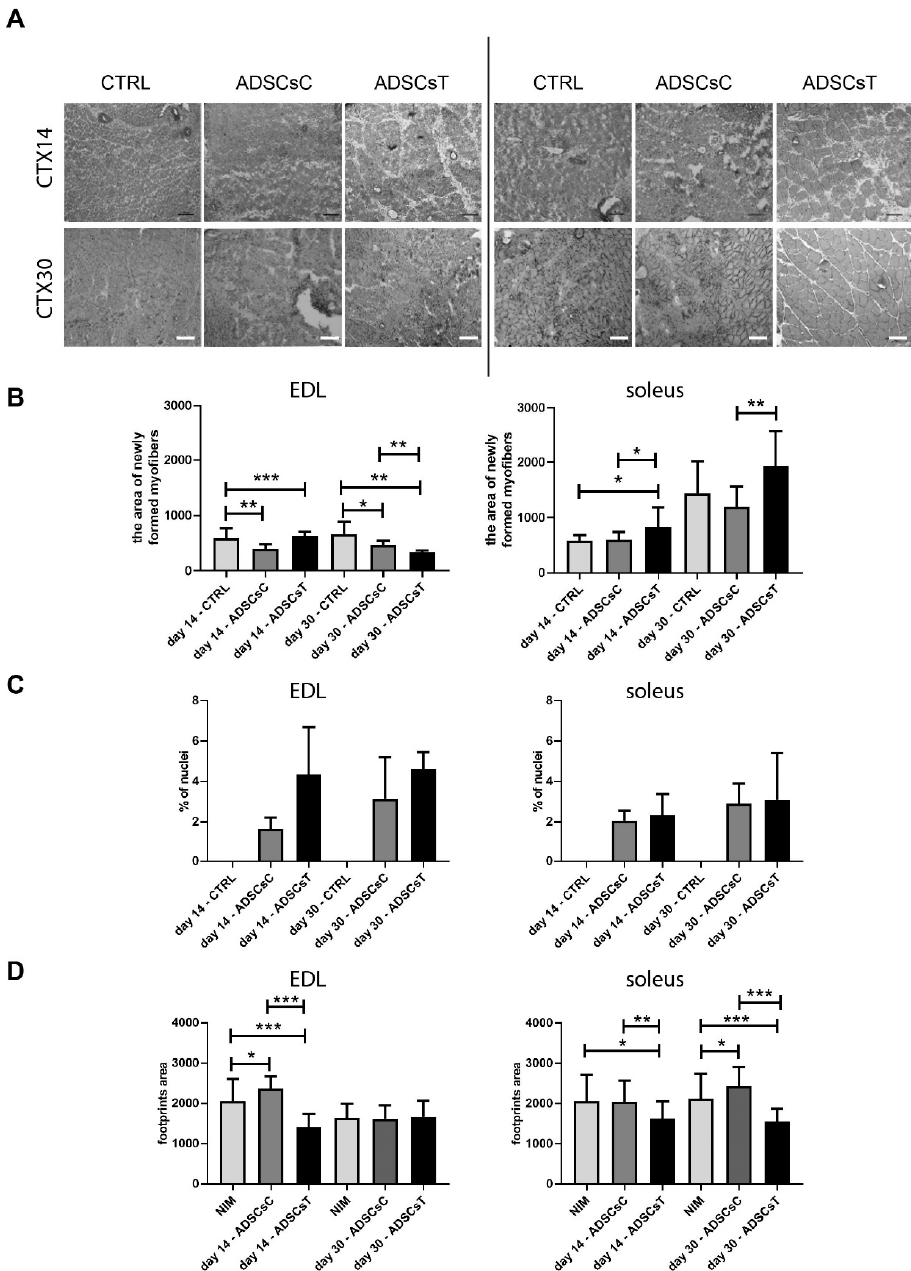
Figure 4. Analysis of muscle morphology, and results of footprint test of rat EDL and soleus skeletal muscles which received control rADSCs or rADSCs pre-treated with IL-4 and SDF-1. ( A ) Morphology of regenerating muscles at days 14 and 30 of regeneration. Hematoxylin/Gomori Trichrom staining; bar: 100 µm. ( B ) Area of newly formed myofibers within the regenerating muscle analyzed at days 14 and 30 of regeneration; ( C ) proportion of centrally positioned nuclei within the regenerating muscle analyzed at days 14 and 30 of regeneration; ( D ) results of footprint test done at days 14 and 30 of regeneration. For 1B n is between 6 and 13, for 1C n = 4, for 1D n is between 14 and 39. Data analyzed with of Student’s t -test: 4B, data analyzed with Mann–Whitney U test: 4C, D. Data are presented as mean ± SD. * represents: * p ≤ 0.05; ** p ≤ 0.01, *** p ≤ 0.001. Skeletal muscles injured and injected with NaCl (CTRL), injured and transplanted with control rADSCs (ADSCsC) or IL-4 and SDF-1 treated rADSCs